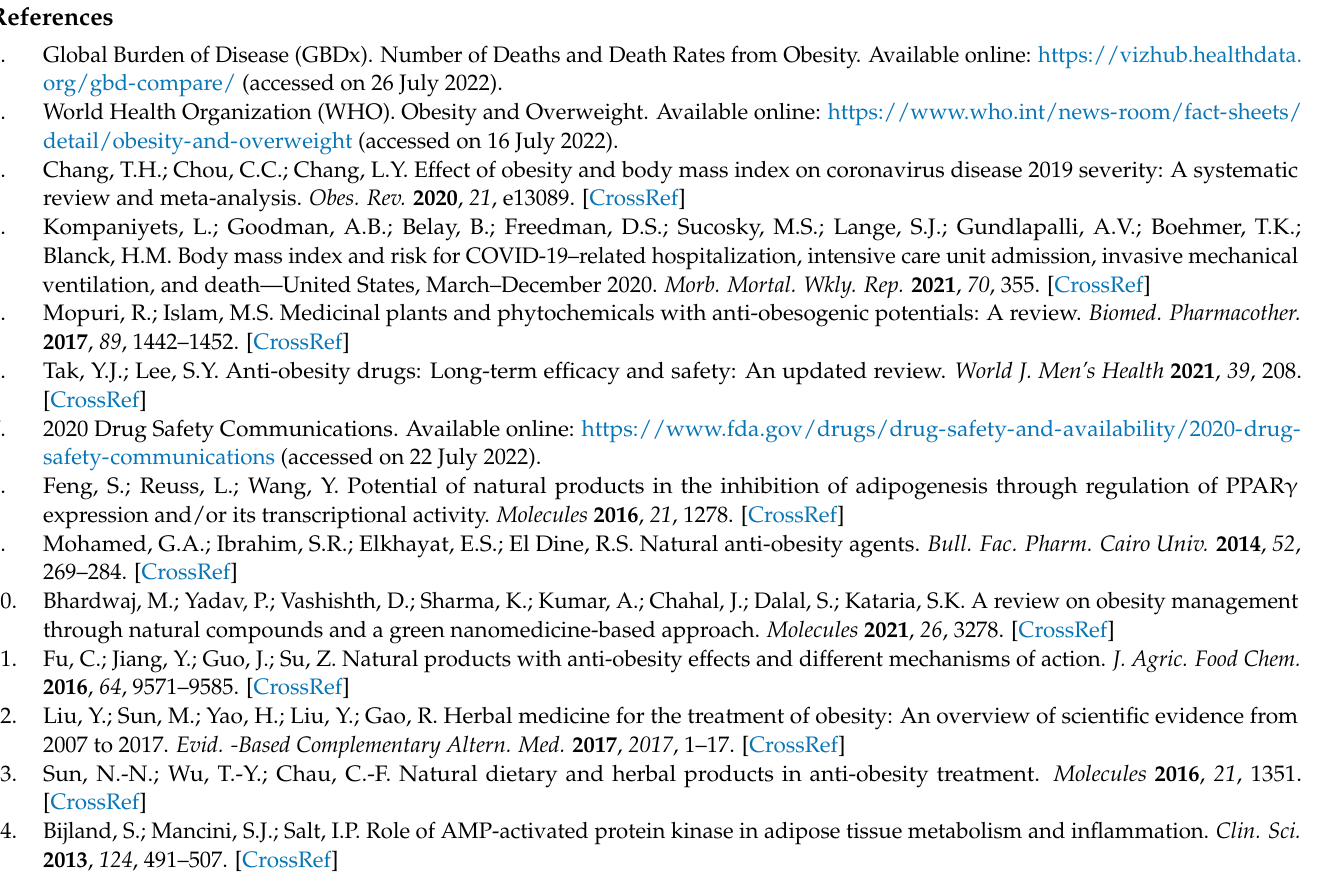
Figure S2: Original western blot images for Figure 6a: Effects of pinostrobin (5, 10, and 20 µ M) on the Akt-related signaling pathway in 3T3-L1 cells; Figure S3: Original western blot images for Figure 6d: Effects of pinostrobin (5, 10, and 20 µ M) on the AMPK-related signaling pathway in differentiated 3T3-L1 cells; Figure S4: Original western blot images for Figure 7a: Effects of pinostrobin (5, 10, and 20 µ M) on the MAPK-related signaling